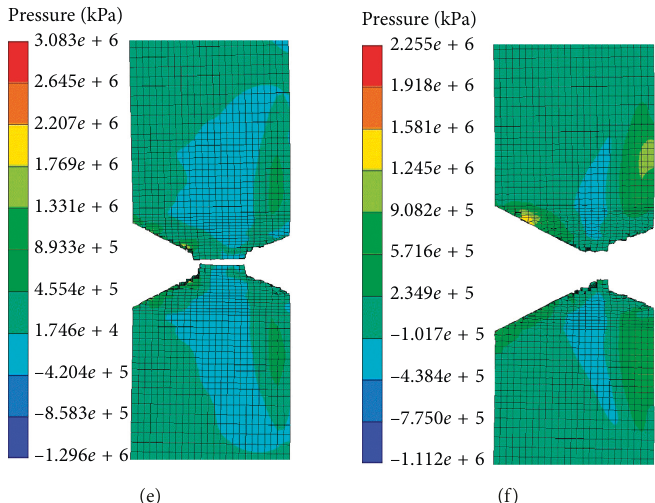
Figure 9: Pressure contours of the connecting rod. (a) 0.050ms. (b) 0.062ms. (c) 0.076ms. (d) 0.090 ms. (e) 0.148ms. (f) 0.154ms.